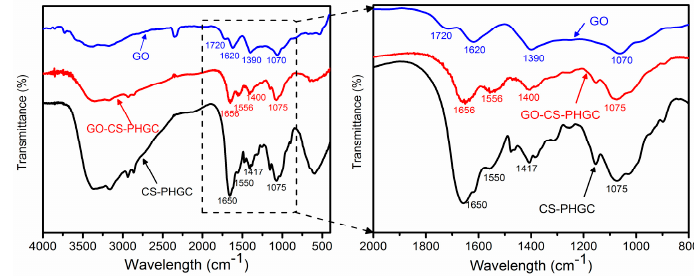
Figure 3. FTIR spectrum of GO, CS-PHGC and GO-CS-PHGC.